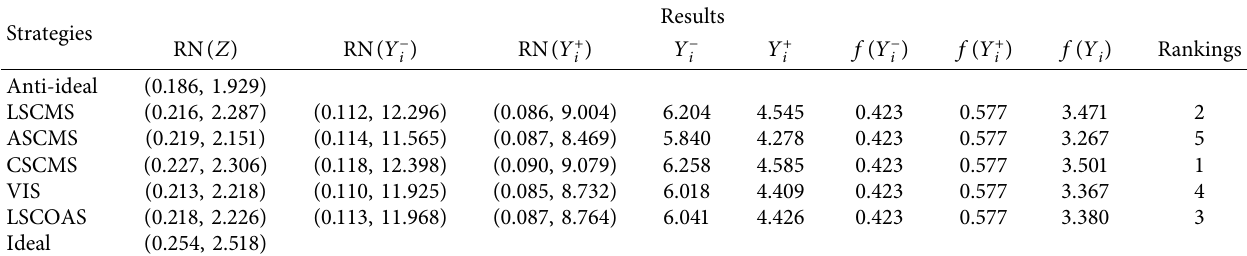
Table 8: Te fndings of rough